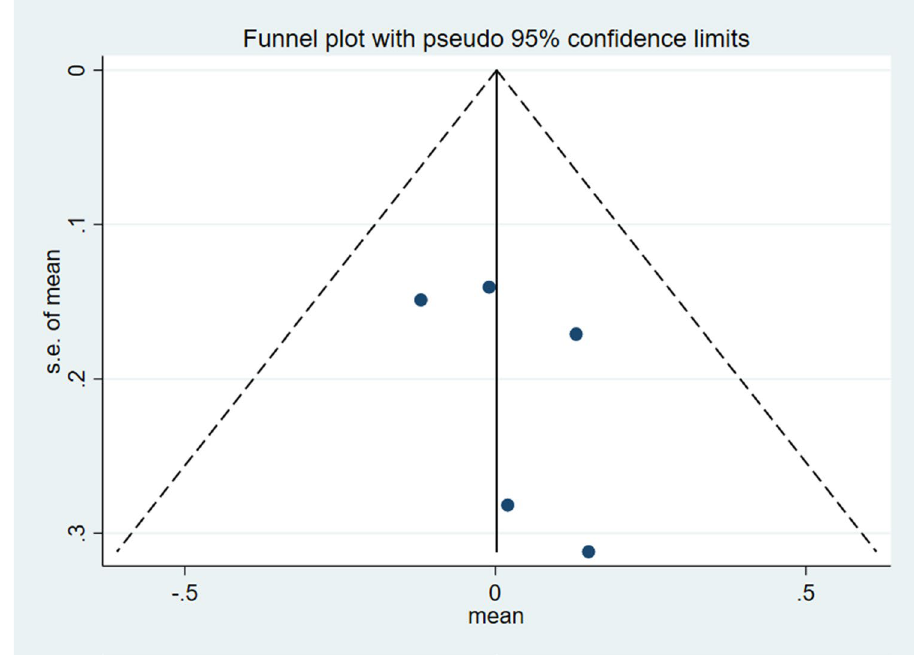
Figure 7. Funnel plot of publication bias for the effect of resistance exercise on the gait knee adduction moment